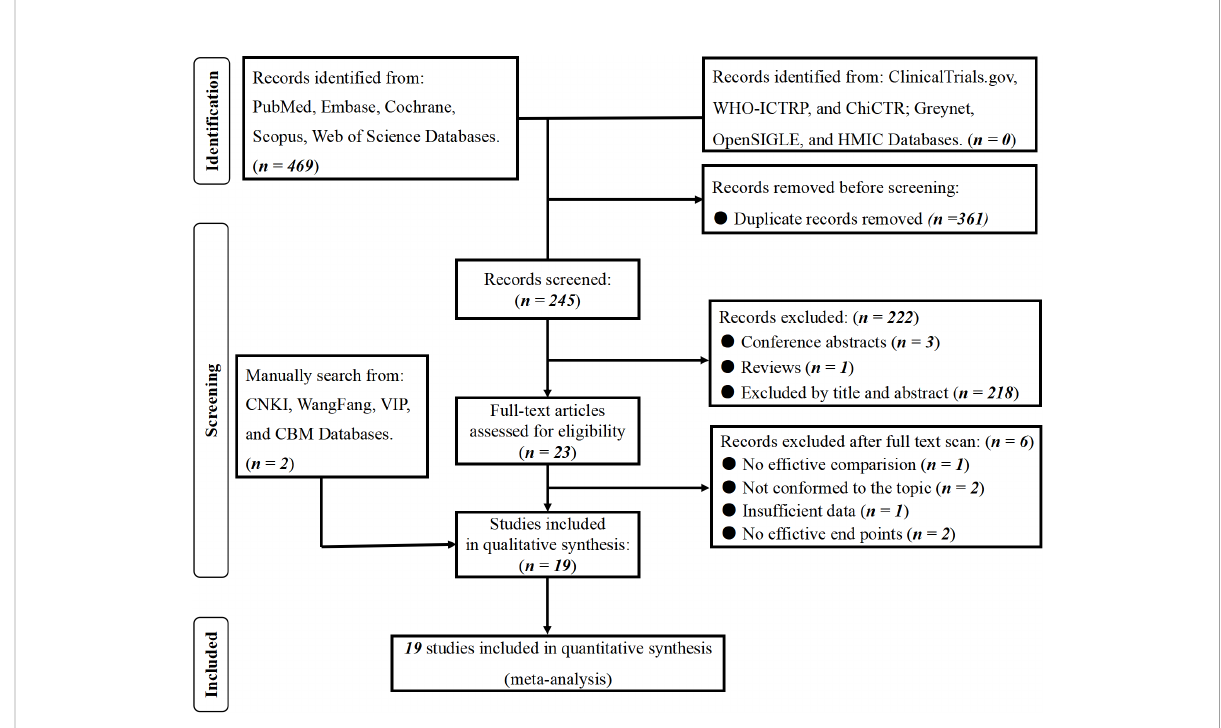
FIGURE 1 PRISMA fl owchart of included